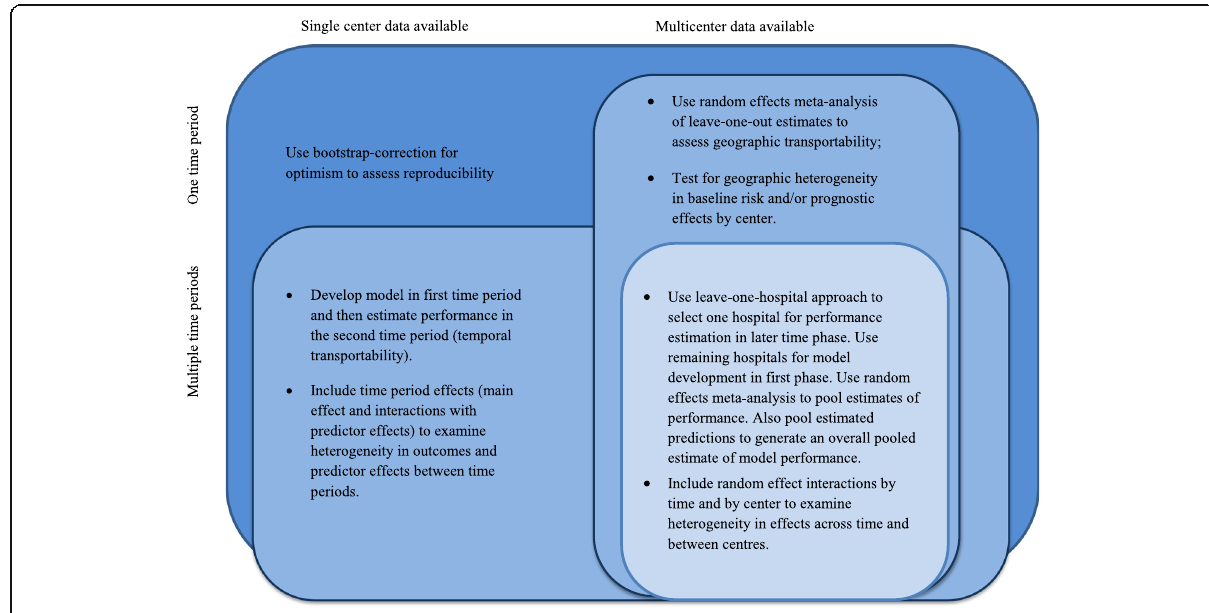
Fig. 1 Recommendations for validating clinical prediction